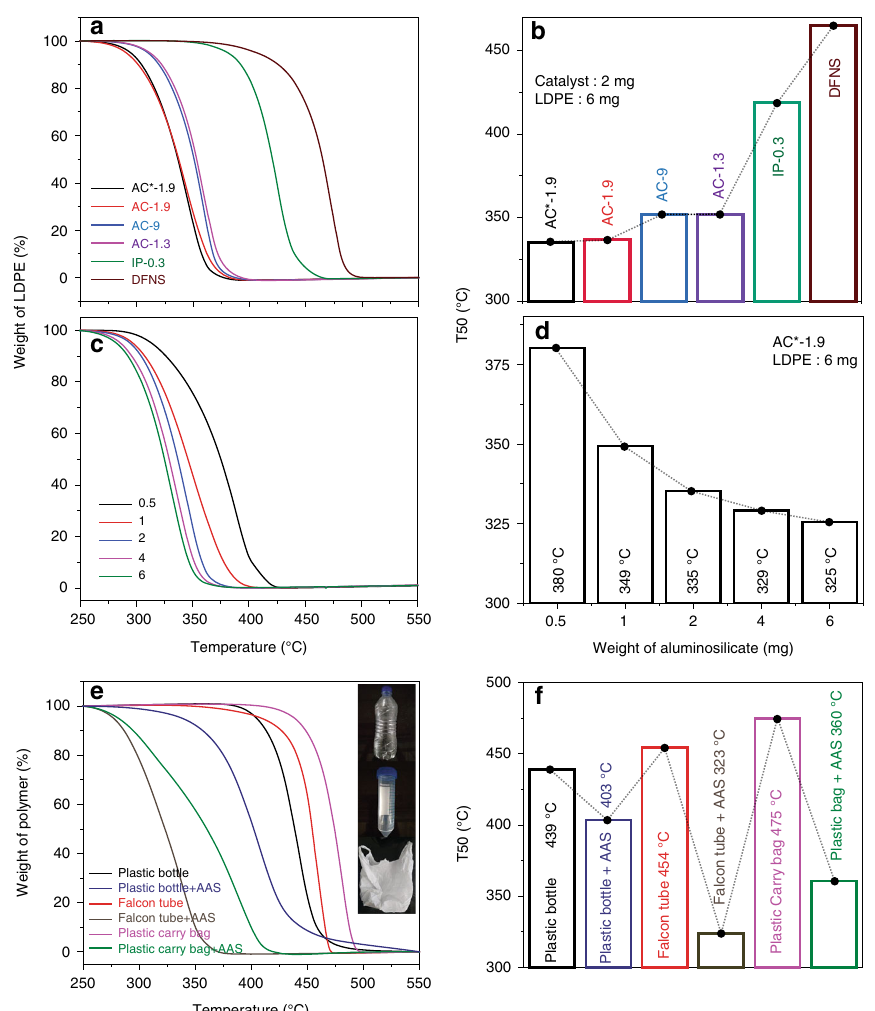
Fig. 8 Household and laboratory plastic degradation using AAS. a Weight loss curve of LDPE pyrolysis using AAS and DFNS; b T50 ’ s of the LDPE pyrolysis using LDPE (6 mg) and AAS AC*-1.9 (2 mg); c weight loss curve and d T50, of LDPE (6 mg) pyrolysis by varying the catalyst (AC*-1.9) amount to 0.5, 1, 2, 4, and 6 mg; e weight loss curve of plastic bottles, falcon tubes, and plastic carrier bags (6 mg each), and f T50, using AAS AC*-1.9 (2 mg). Error in the T50 is ± 3